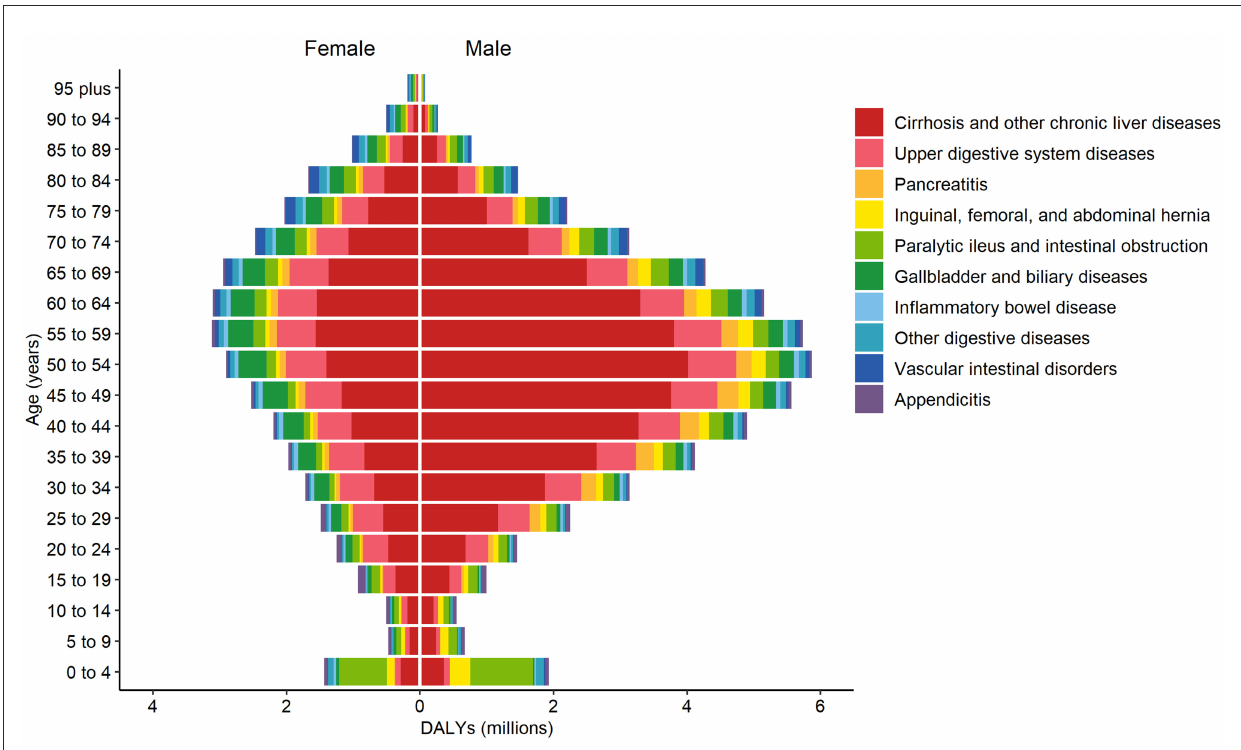
FIGURE2 Global DALYs by digestive diseases, sex, and age, 2019. DALYs, disability-adjusted life-years.